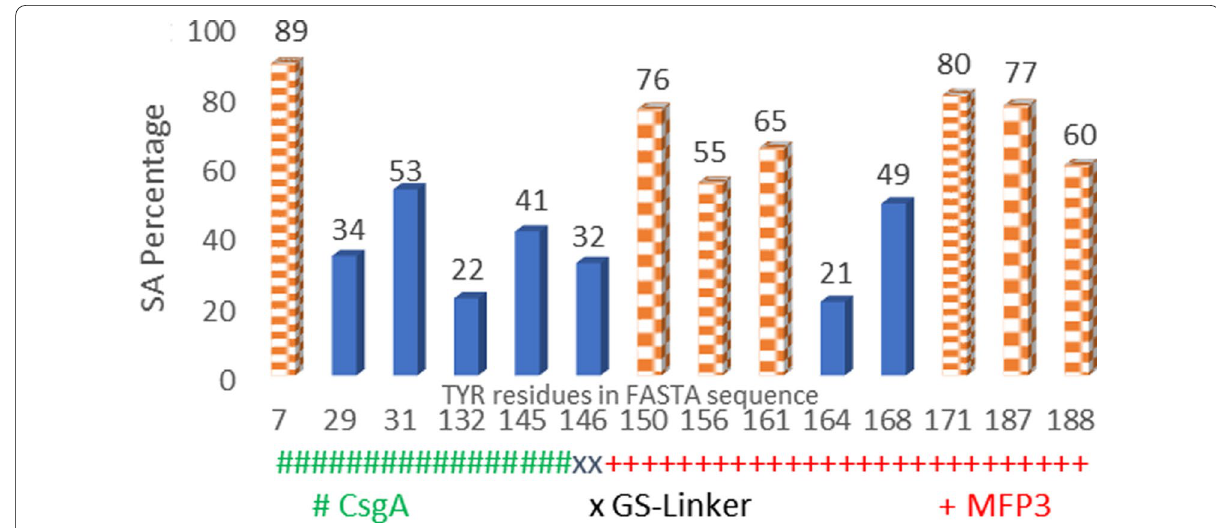
Fig. 3 Data from the percentage of tyrosine surface area and determination of the manually modified by PyMOL. Manually modified Tyr residues with more than 55% of the quantified surface area. Unmodified tyrosine residues with less than 55% surface area. Six out of eight tyrosines in the MFP3 residue have been modified, which means that the tyrosine amino acids in the MFP3 structure are more accessible to tyrosinase activity than five unmodified tyrosines in the CsgA